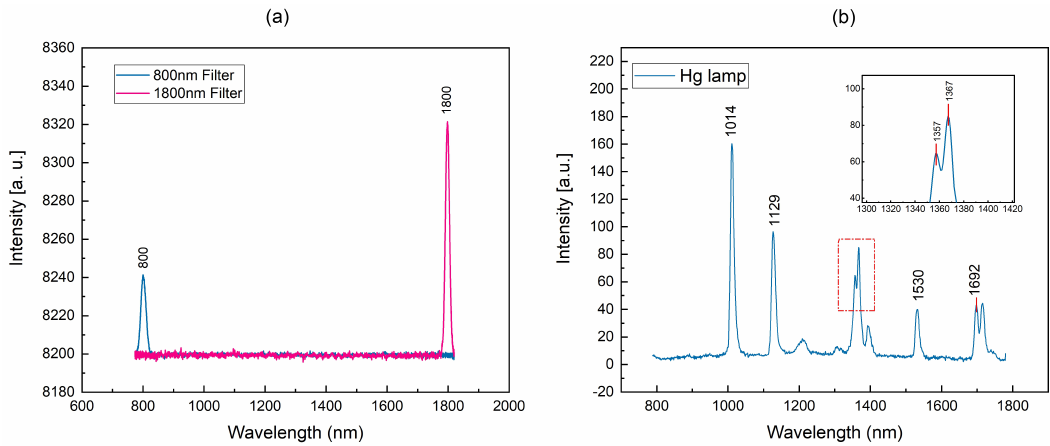
Figure 4. ( a ) Wavelength range; ( b ) spectral resolution.